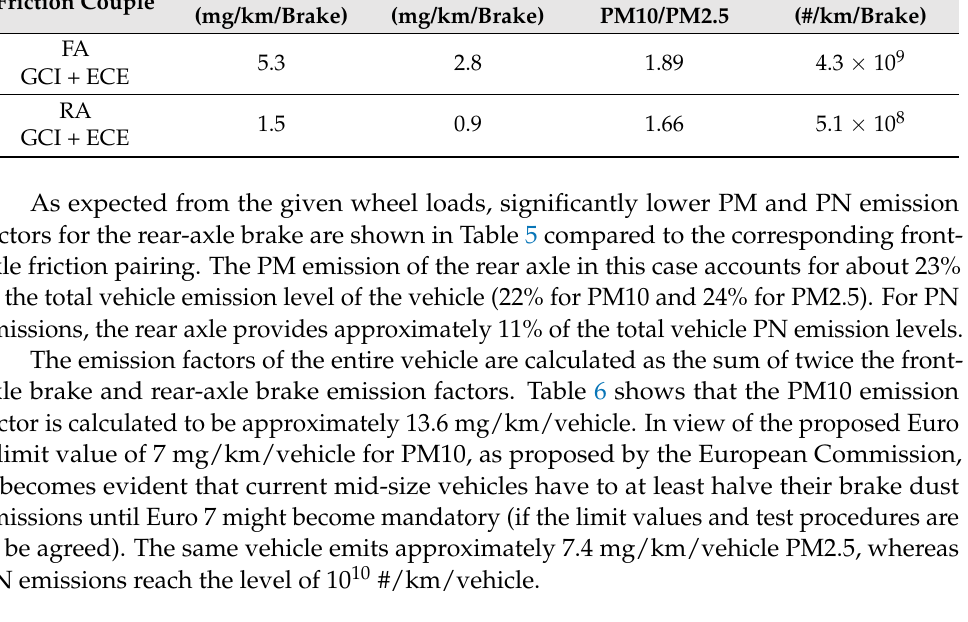
Table 6. Total vehicle emission factors of the C-segment